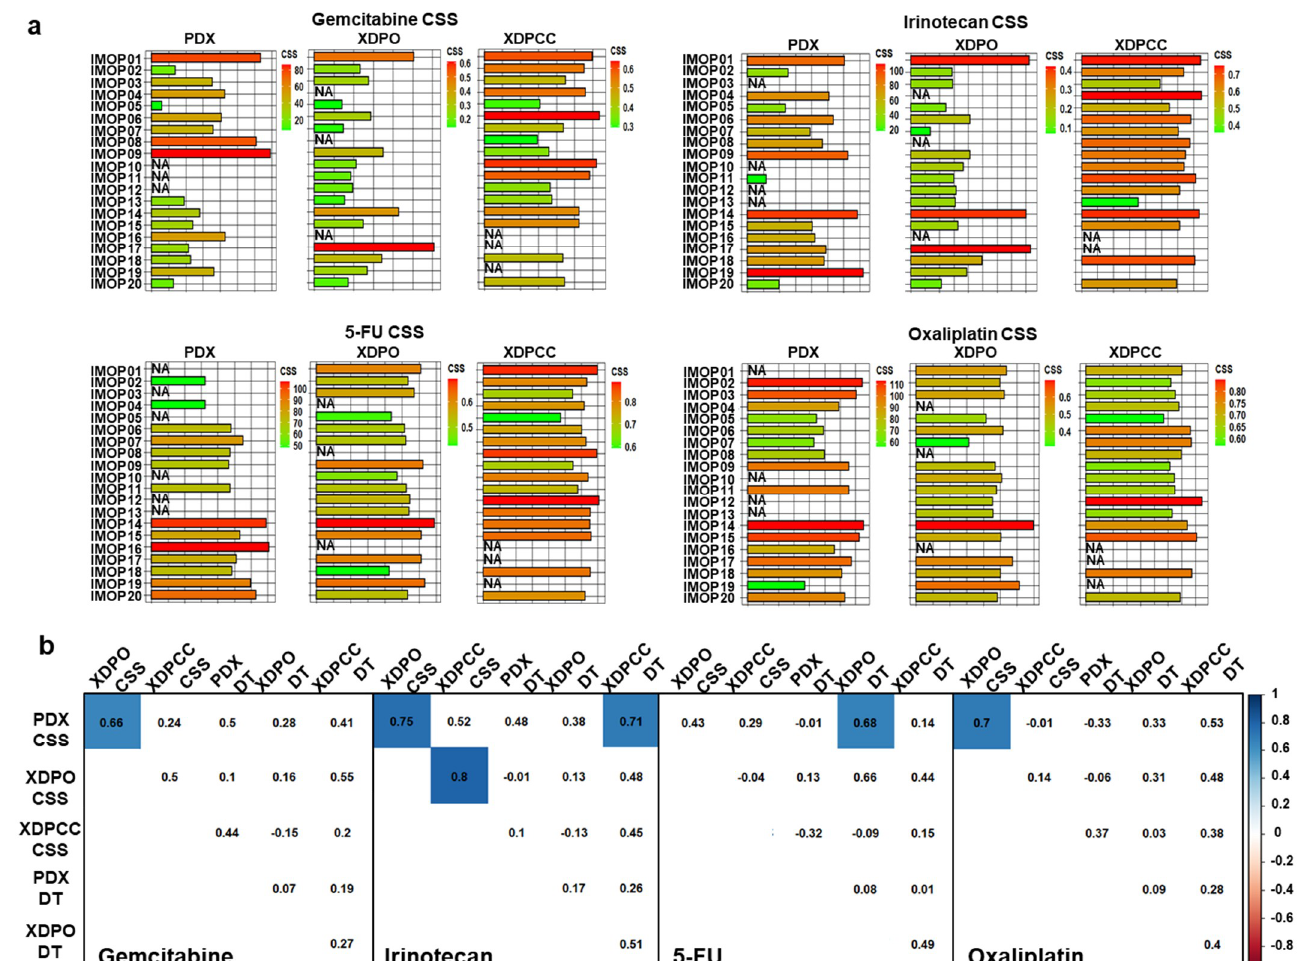
Figure 3. Chemosensitivity score for PDX, XDPO and XDPCC. ( a ) Barplots were generated comparing the chemosensitivity score (CSS) of all models (IMOP01 – IMOP20) treated with gemcitabine, irinotecan, 5-FU, and oxaliplatin respectively. Bars in red with a higher CSS indicate more resistance and bars in green with a lower CSS indicate more sensitivity. Non-available (NA) values for some models show no bars. ( b ) Correlation plots comparing the drug sensitivity profile and mean doubling time of all models for gemcitabine, irinotecan, 5-FU, and oxaliplatin. Statistically significant correlations are highlighted in blue squares as p- values of 0.05 or less.